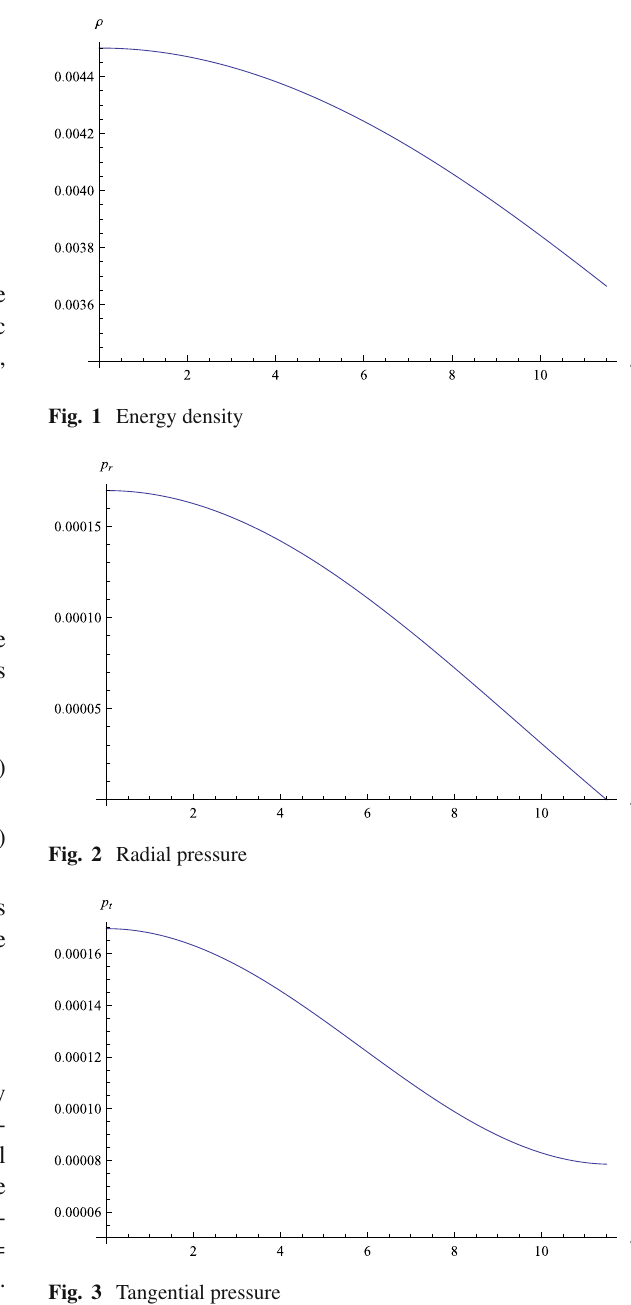
Fig. 3 Tangential